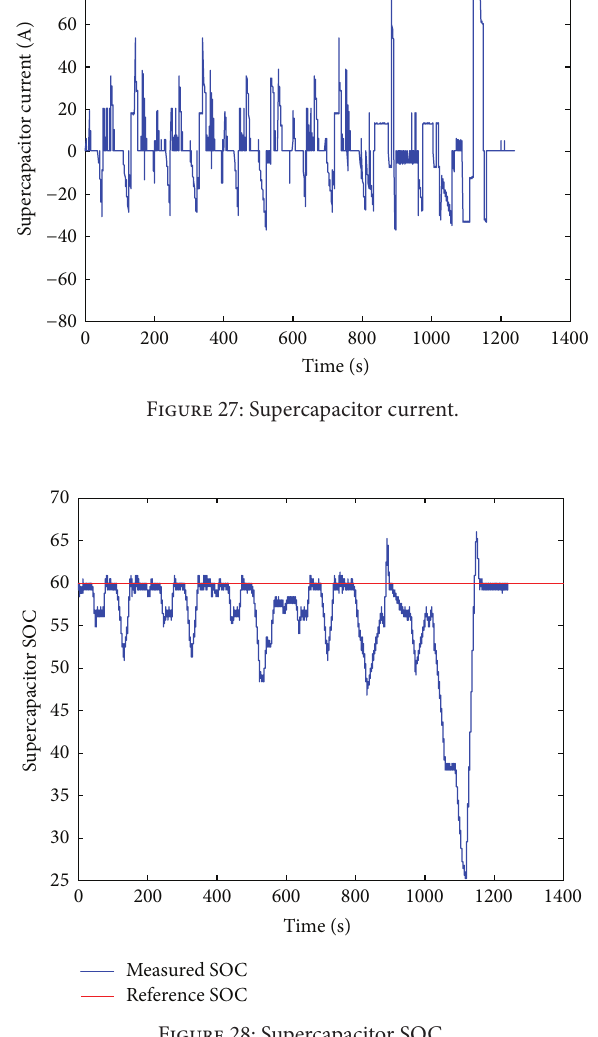
Figure 28: Supercapacitor SOC.